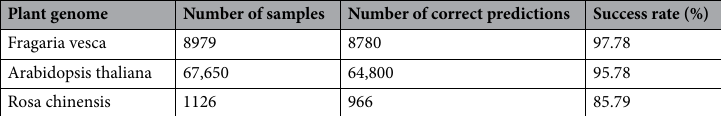
Positive negative sample